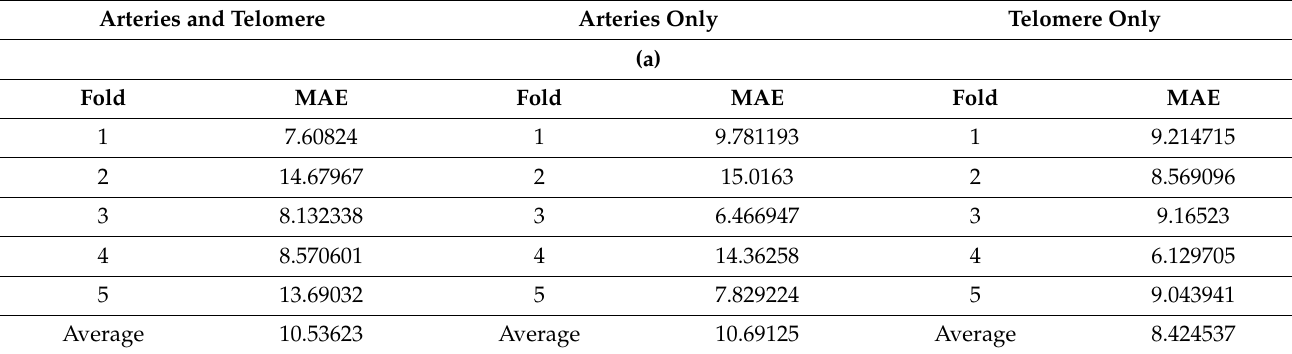
Table 5. ( a ) Mean absolute errors for systolic BP predictions (Age group 1). ( b ) Mean absolute errors for systolic BP predictions (Age group 2). ( c ) Mean absolute errors for systolic BP predictions (Age group